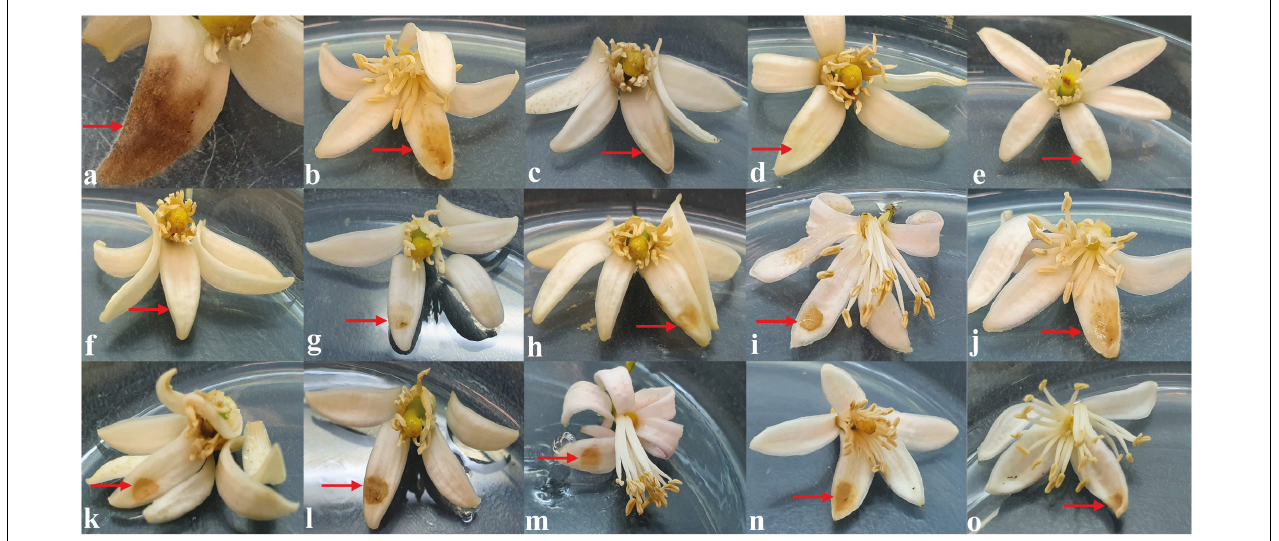
FIGURE 4 | In vitro assay to evaluate the activity of the extracts to inhibit the development of post-bloom fruit drop (PFD) in citrus flowers, 48 h after inoculation with 5 µ L of conidial suspension of Colletotrichum abscissum (10 6 conidia/mL; red arrows) added with: (a) 5 µ L of saline solution (showing the characteristic symptom of PDF), (b) 5 µ L of methanol (control), (c) 10 µ L with carbendazim (Derosal – control), and 5 µ L of each endophytic extracts: (d) Diaporthe vochysiae CMRP4322, (e) Nemania primolutea CMRP4323, (f) Pseudofusicoccum stromaticum CMRP4328, (g) D. vochysiae CMRP4321, (h) D. vochysiae CMRP4326, (i) D. vochysiae